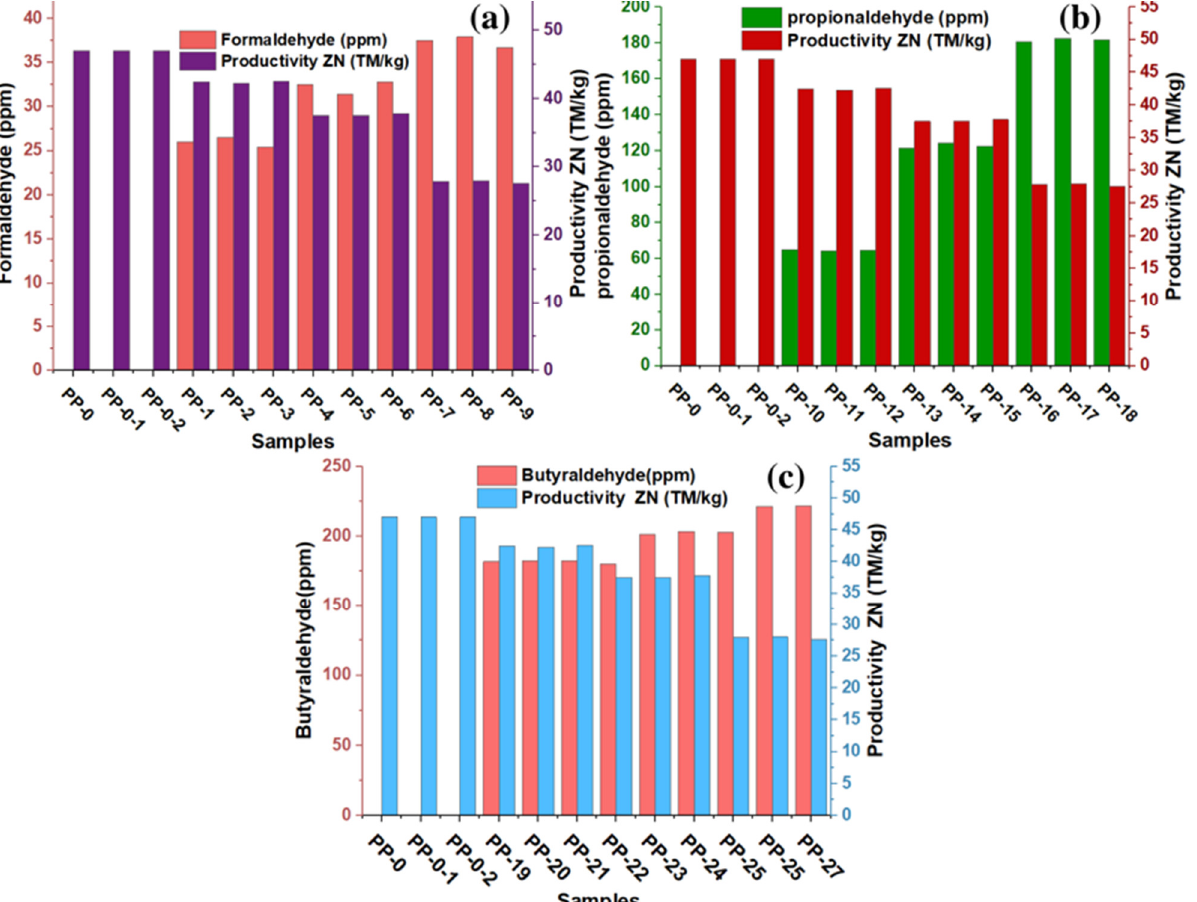
Figure 2. Effect of trace formaldehyde ( a ), propionaldehyde ( b ), and butyraldehyde ( c ) on the efficiency of copolymer synthesis.